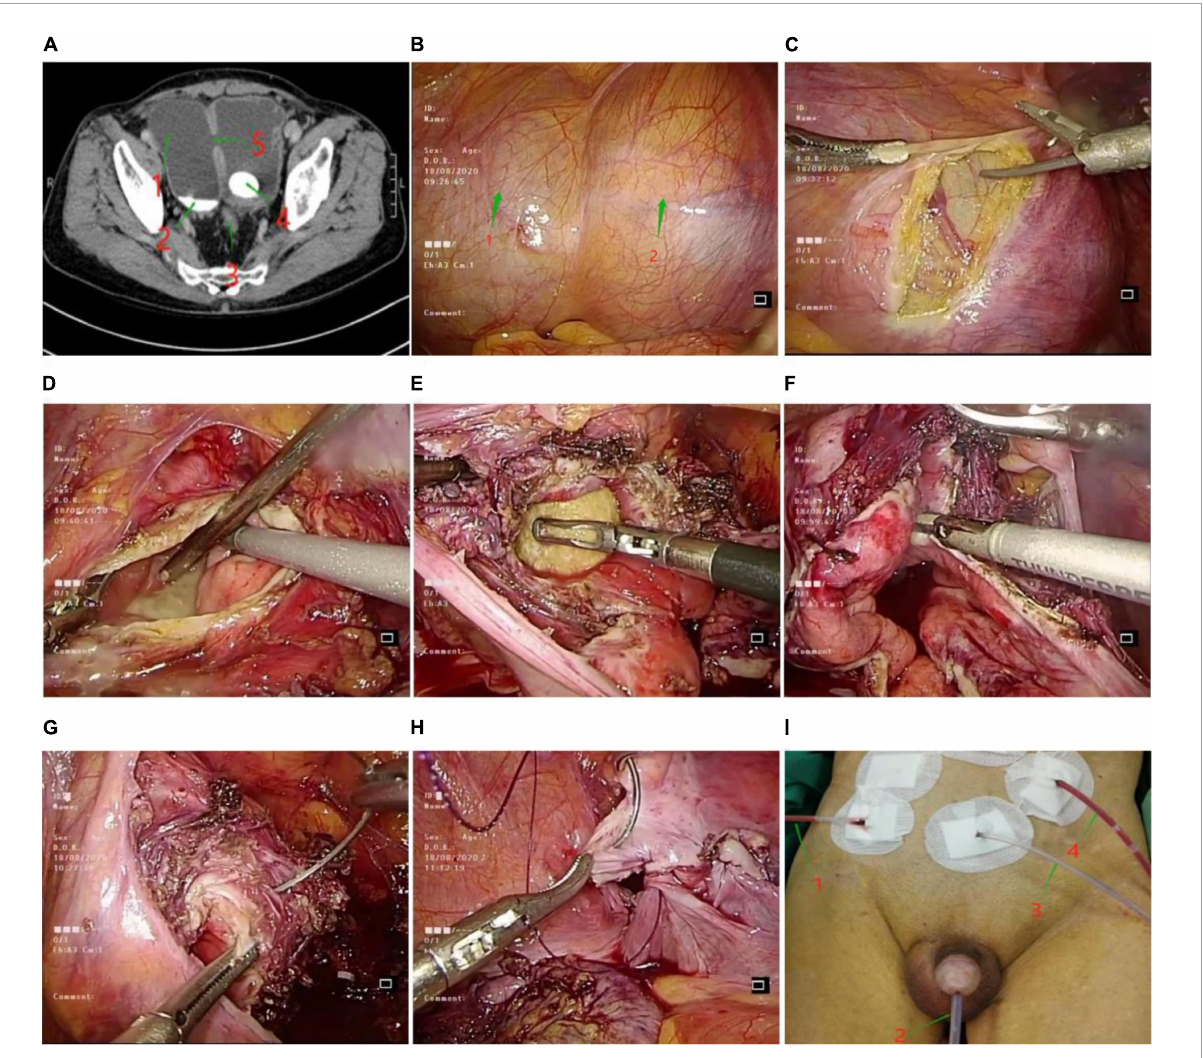
FIGURE2 (A) Abdominal CT. 1: Bladder diverticulum; 2: Sedimentary stone; 3: Hyperplasia of prostate; 4: Bladder stone; 5: Orifice of bladder diverticulum. (B) a naturally full bladder under laparoscopy. 1: Naturally filled bladder under laparoscopy; 2: Naturally filled bladder diverticulum under the abdominal cavity. (C) Incision of bladder diverticulum with ultrasonic scalpel. (D) Removal of sediment-like stones in bladder diverticulum. (E) Enlarged neck of bladder diverticulum, huge bladder stone removal. (F) Ultrasound scalpel to remove bladder diverticulum tissue. (G)